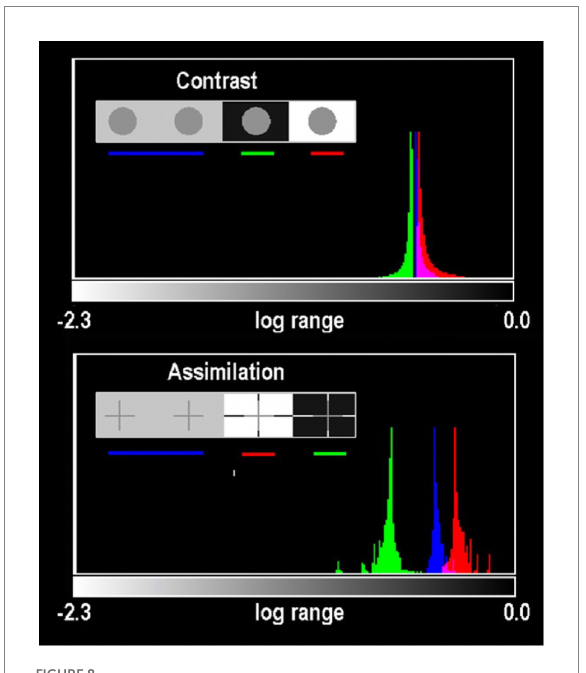
FIGURE 8 Histograms of all Gray pixels in Contrast (circles) and Todovoric Assimilation (crosses) in different backgrounds. Plots of retinal_ contrast_log scaled to l og_range = [ − 2.3,0.0] vs. pixel count. The vertical axis is a linear count (256 bins). Each histogram is normalized to its own peak. Gray-in-Black surrounds are green; Gray-in-gray are blue; Gray-in-White are red. In Assimilation crosses, glare adds more light to Gray segments that appear lighter in White, and the least light to Grays that appear darker in Blacks (Figure 7A). The opposite happens in the Contrast’s circles, showing Glare’s